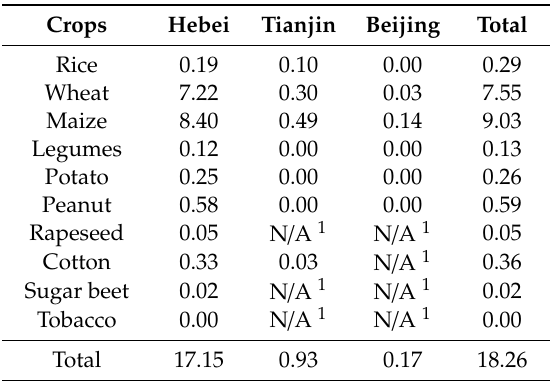
Table 4. Crop residue coal equivalent calculations in 2017 (10 6